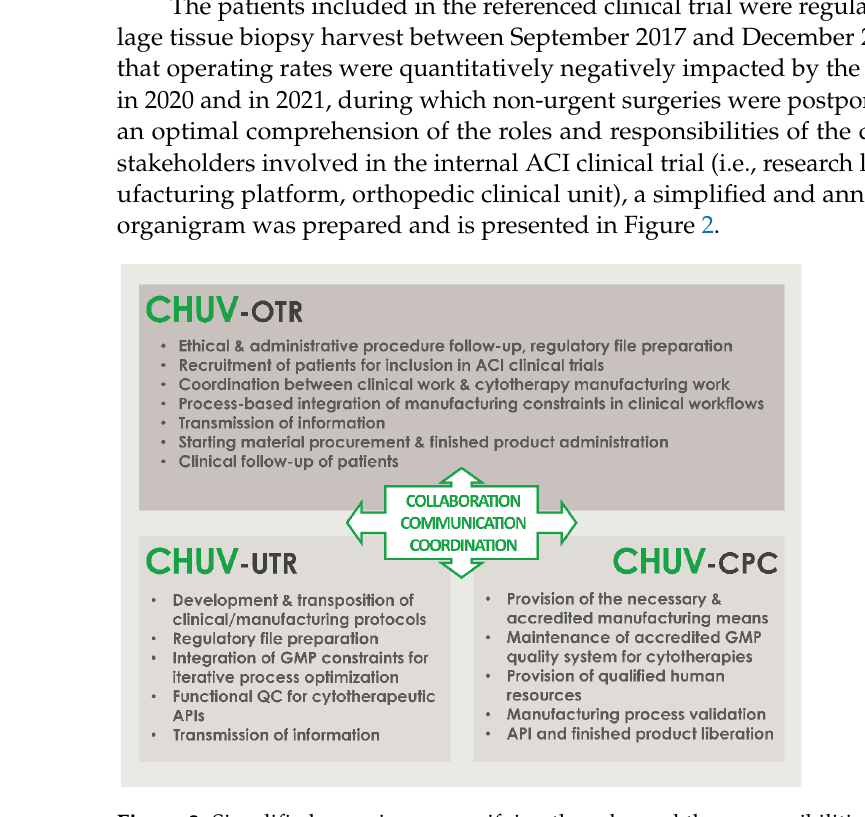
Figure 2. Simplified organigram specifying the roles and the responsibilities of the different CHUV professional stakeholders involved in the internal ACI clinical trial (i.e., research labora- tory, GMP manufacturing platform, orthopedic clinical unit) within the CHUV. Critical im- portance is set on the effective collaboration, communication, and coordination between all of the stakeholders. ACI, autologous chondrocyte implantation; API, active pharmaceutical ingredient; CHUV, centre hospitalier universitaire vaudois; CPC, cell production center; GMP, good manufac- turing practices; OTR, orthopedics and traumatology service; QC, quality control; UTR, regenera- tive therapy unit. As regards the original data related to in vitro cell isolation from the cartilage tissue biopsies, various elements from the available manufacturing records are presented here- after. Notably, photographic records of tissue bioprocessing and of in vitro HAC cell cul- ture are presented in the form of an illustrative overview in Figure 3.